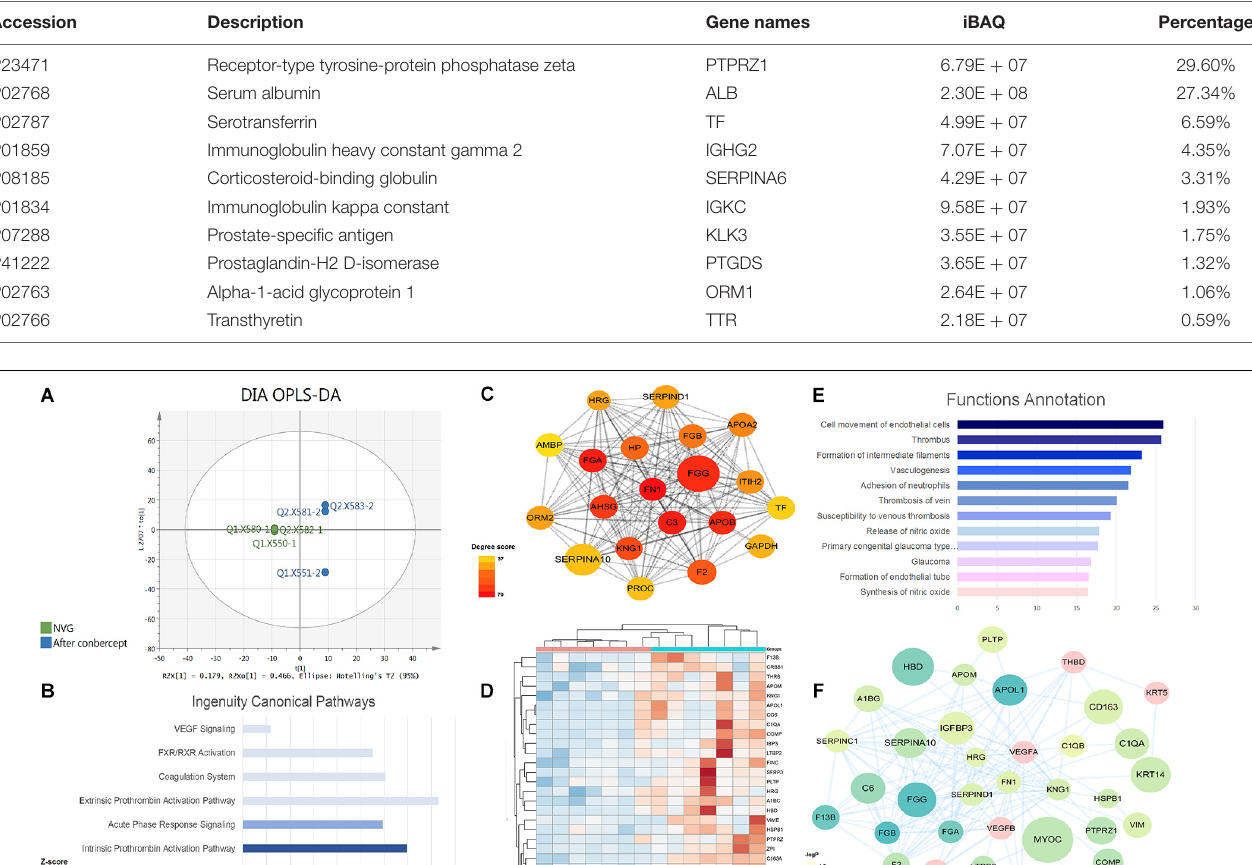
TABLE 2 | The 10 most abundant proteins in AH.